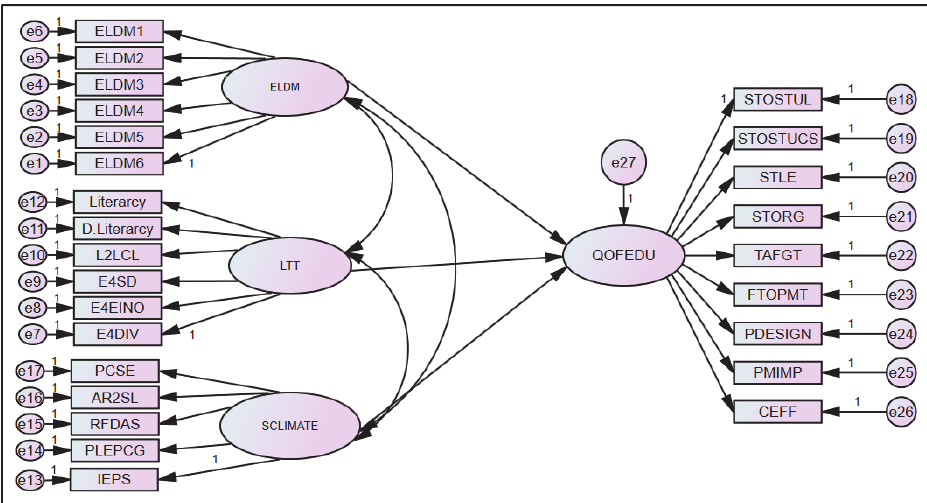
Fig. 5. Structural Equation Model of the